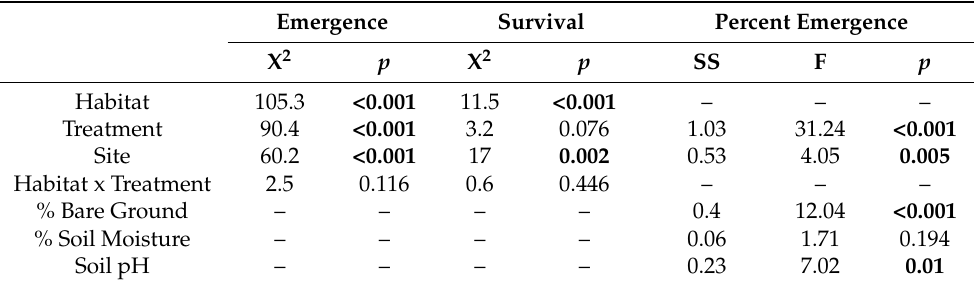
Table 1. Summary statistics for each treatment on poison ivy ( Toxicodendron radicans ) seedling emergence in the first year and survival over the course of the three-year study, as well as summary statistics for site characteristics on percent seedling emergence per plot in the first year. Treatment was for “treated” versus “untreated” drupes, while habitats were forest interior and forest edge. Emergence